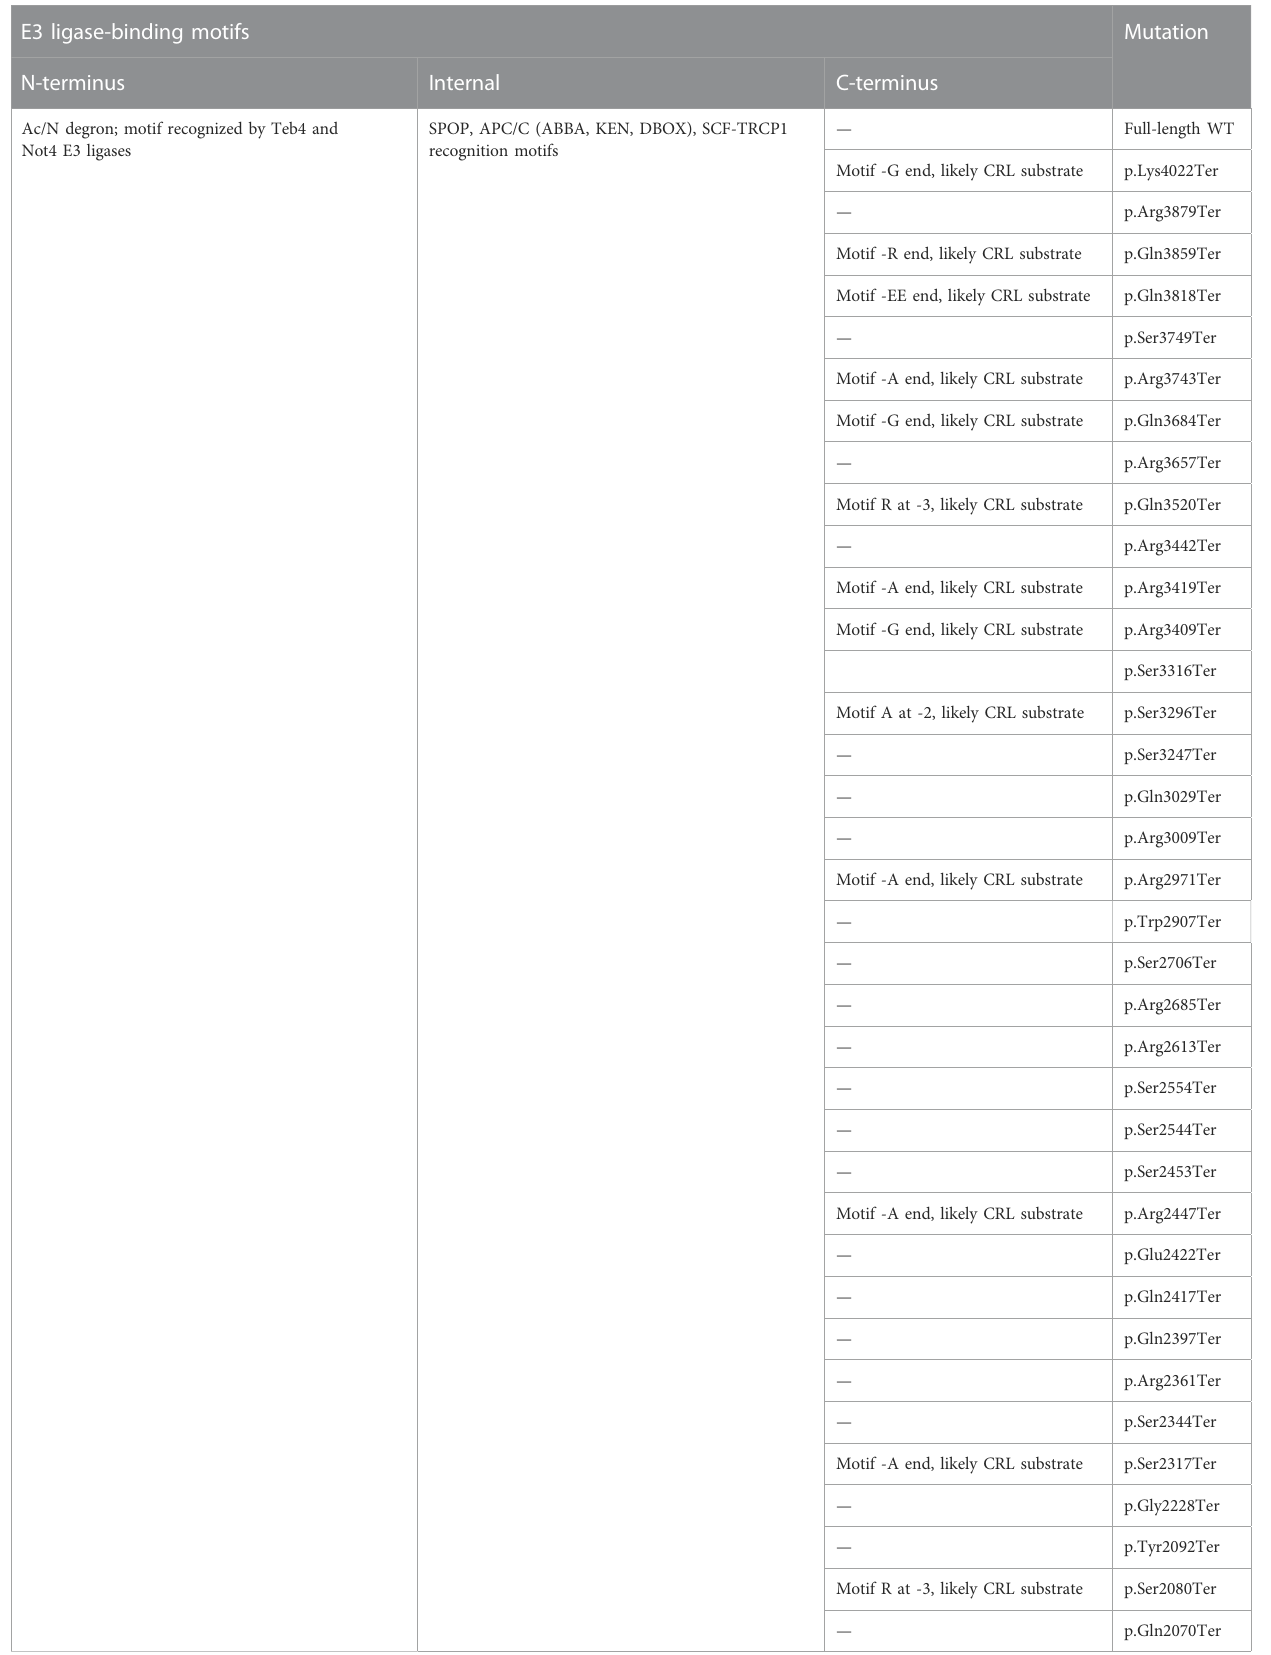
TABLE 2 List of recurrent pathogenic nonsense mutation and their degrons in comparison to the wild-type pro fi